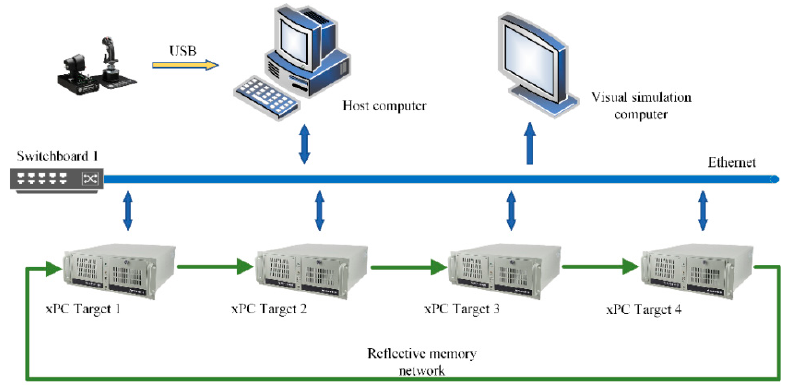
Figure 4. The architecture of the distributed simulation platform.